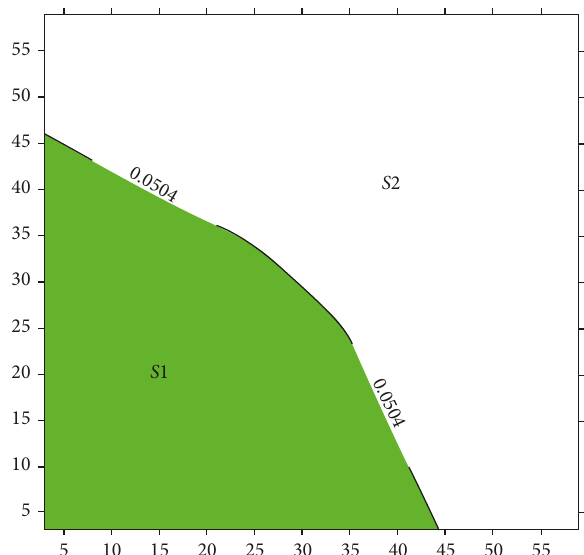
Figure 22: Schematic diagram of the area ratio.